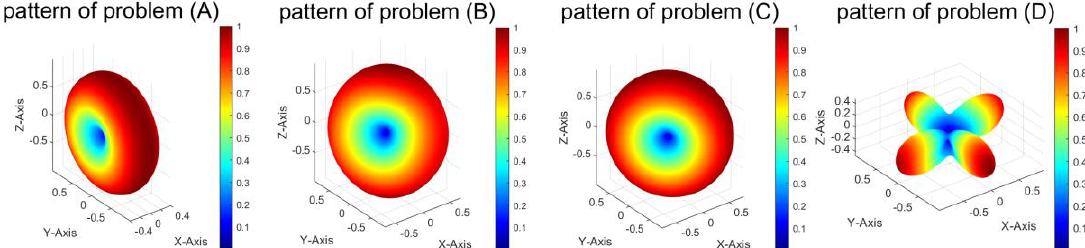
Figure 9. Normalized characteristic patterns of mode 2 for the four different problems at 2.0 GHz.